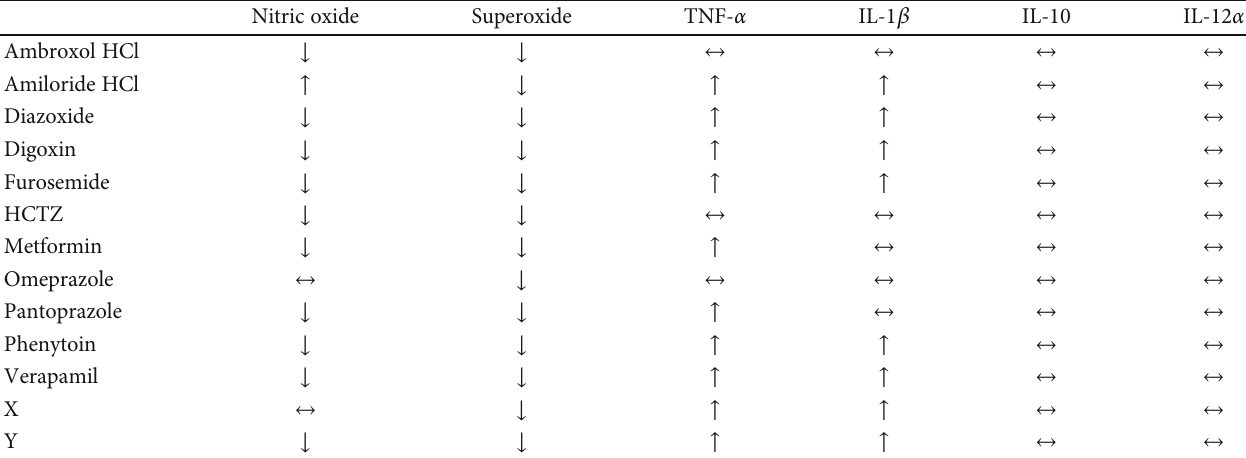
Figure 3: E ff ect of ion transport modulators on cytokine expression by macrophages. Macrophages were stimulated with ethanol-inactivated M. bovis BCG in the presence of the test drugs over 24 hours. RNA expression levels in the drug-treated cultures relative to the drug-free controls were calculated using the Livak method. Data are presented as mean (+SD) of two replicates. ∗ indicates p < 0 : 05 vs. drug-free controls. HCTZ: Table 3: Summary of immunomodulatory activity of ion transport modulators.